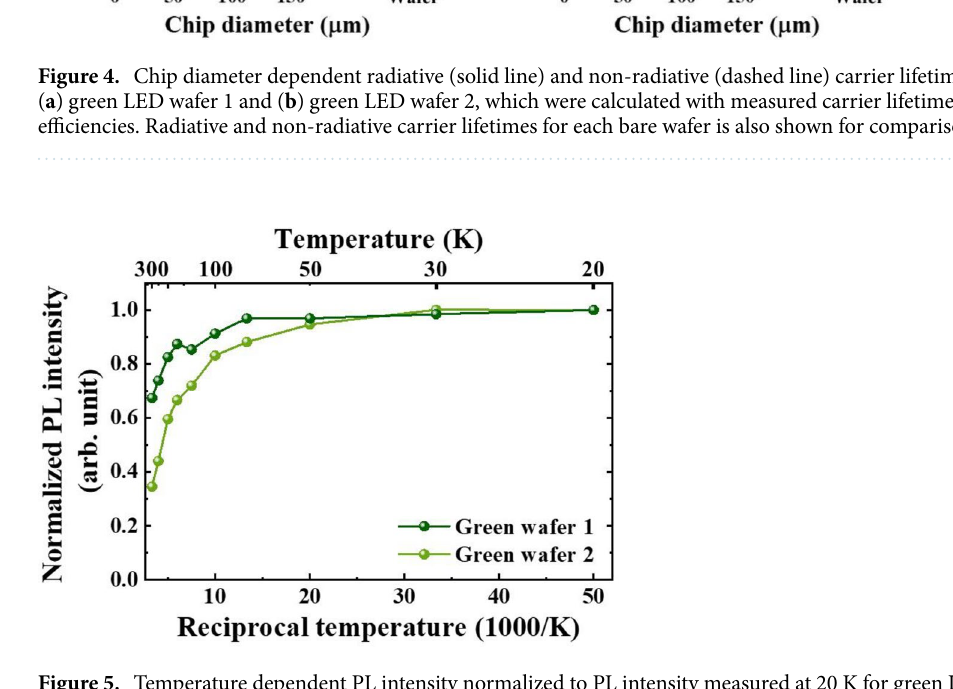
Figure 5. Temperature dependent PL intensity normalized to PL intensity measured at 20 K for green LED wafers 1 and